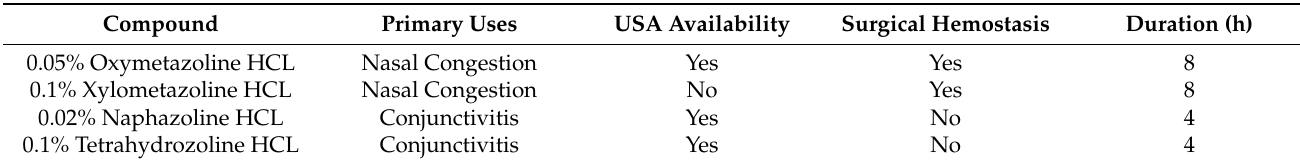
Table 1. Commercially Available Solutions of Imidazoline Derivatives (ImDs) 1 .